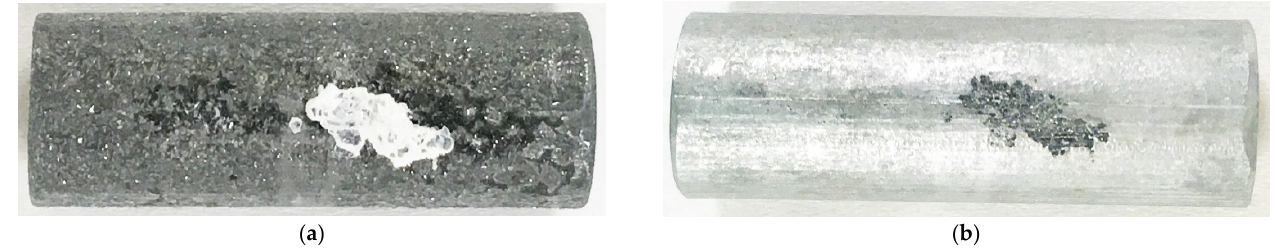
Figure 10. Zn sample exposed in oxygen free AGW for 12 weeks ( a ) before and ( b ) after